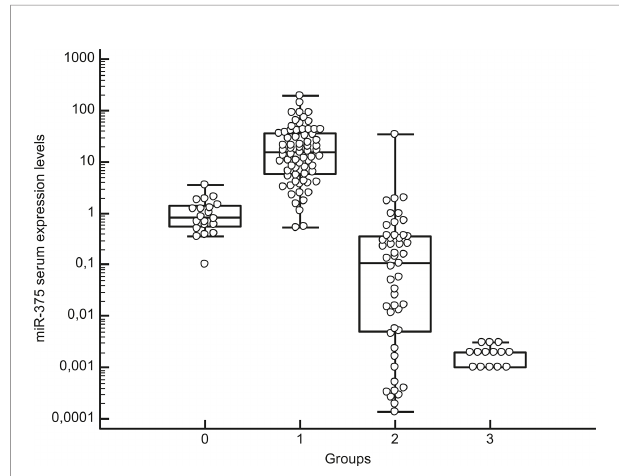
FIGURE 1 | Box-whisker plot graph representing the medians, minimum and maximum values and interquartile ranges (IQR) of serum miR-375 levels in different groups: group 0: healthy subjects, group 1: MTC patients, group 2: patients with thyroid non-C-cell nodular diseases (non-CTN), group 3: pheochromocytoma patients. Values are represented on a logarithmic scale.